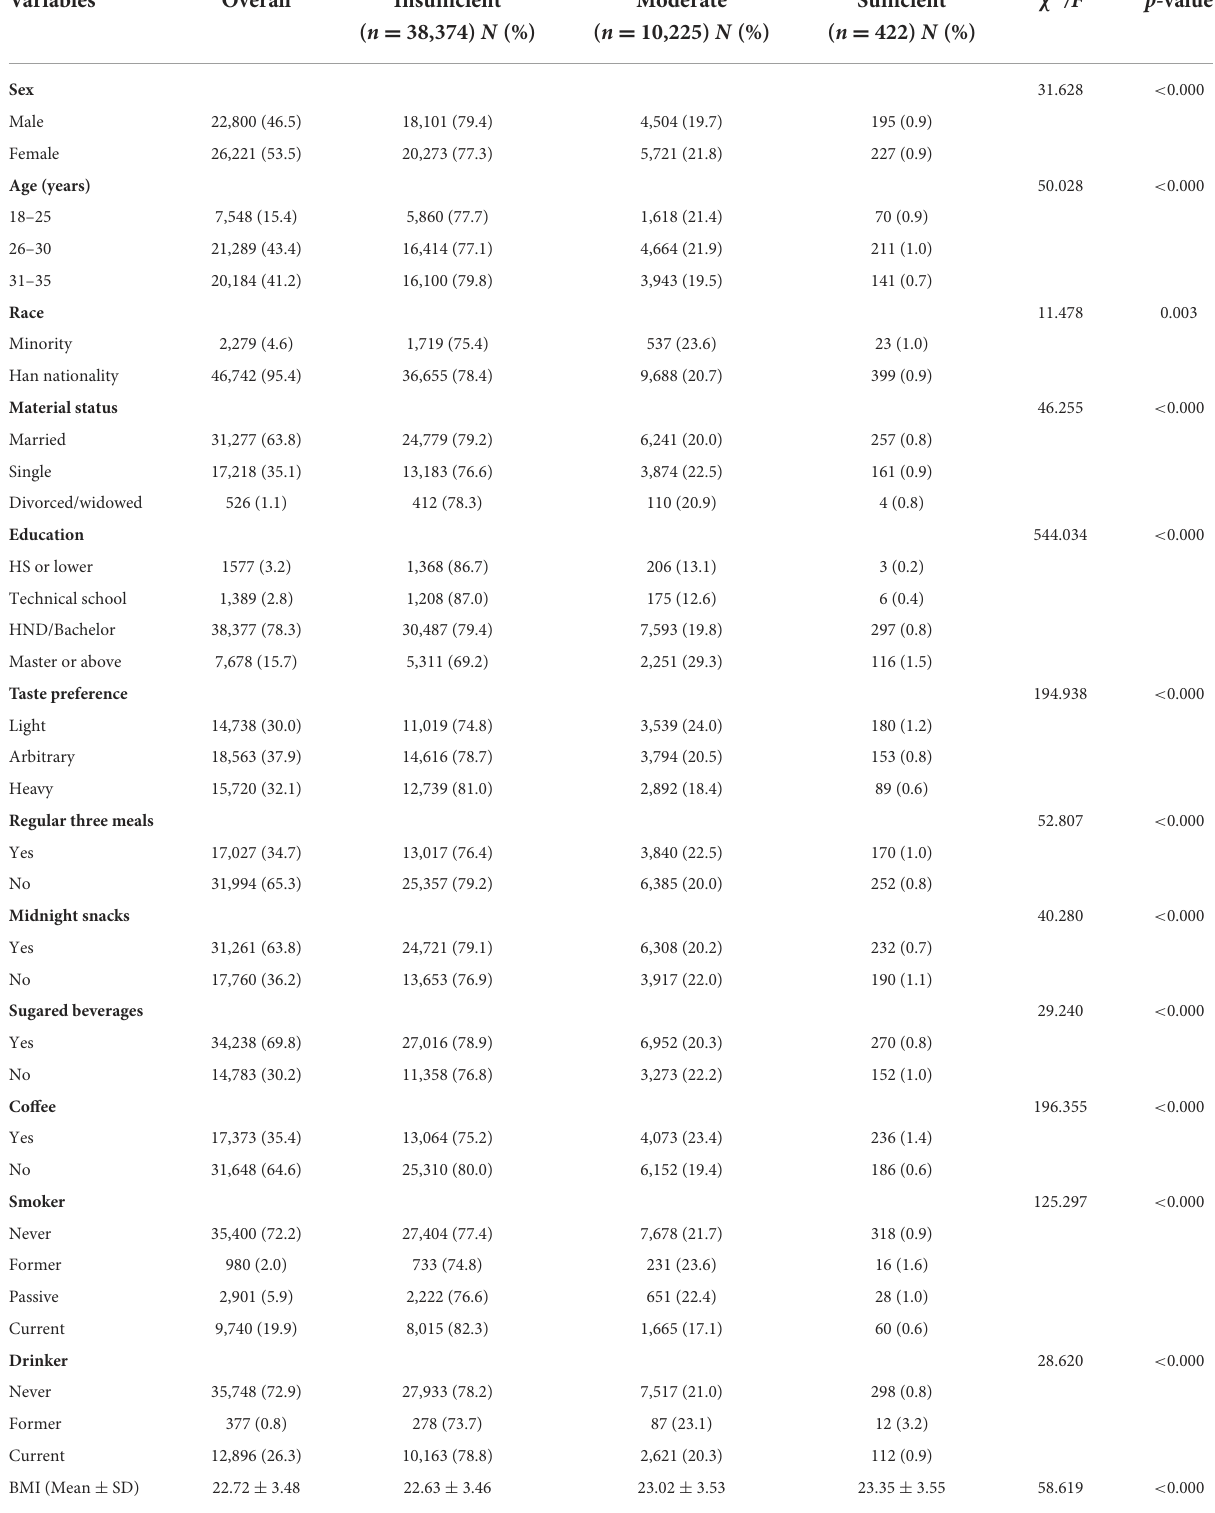
TABLE 2 Demographic characteristics of samples across the three dimensions of dietary diversity score ( n =